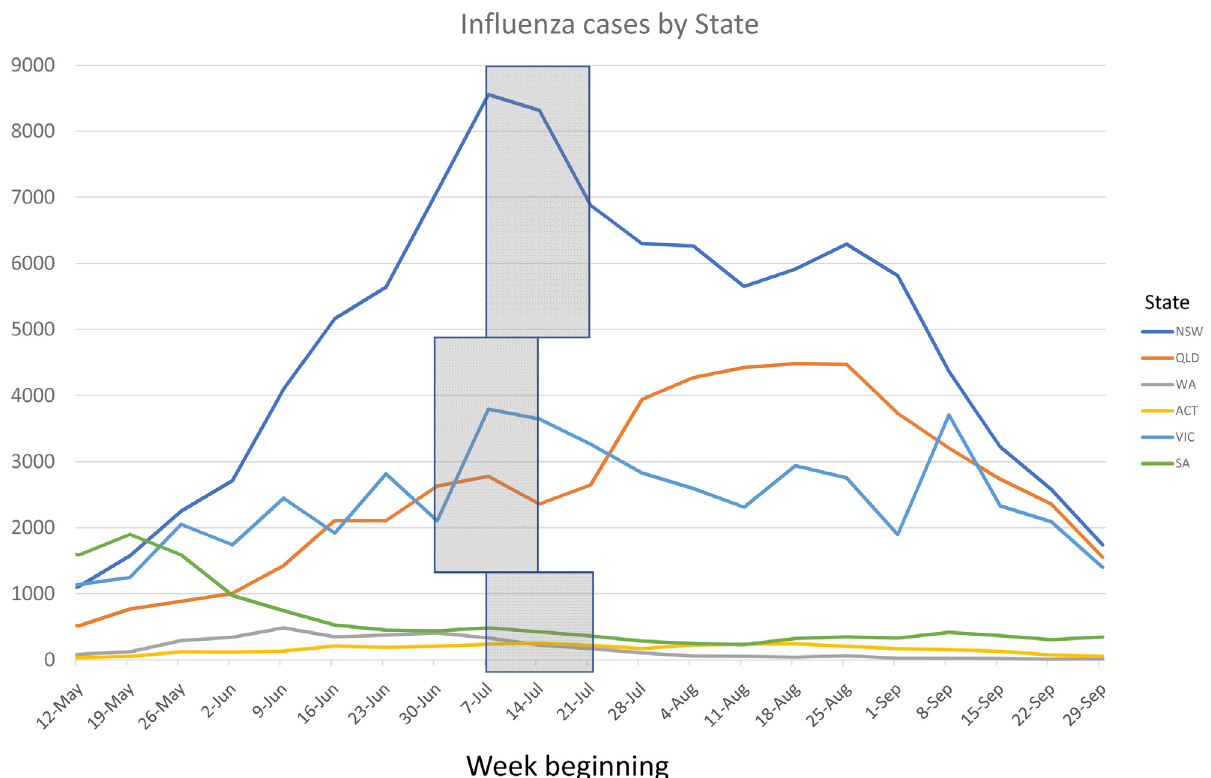
Figure 1. Rates of influenza for the included Australian states and territory (boxes show school holidays periods). NSW, New South Wales; QLD, Queensland; WA, Western Australia; ACT, Australian Capital Territory; VIC, Victoria; SA, Southern